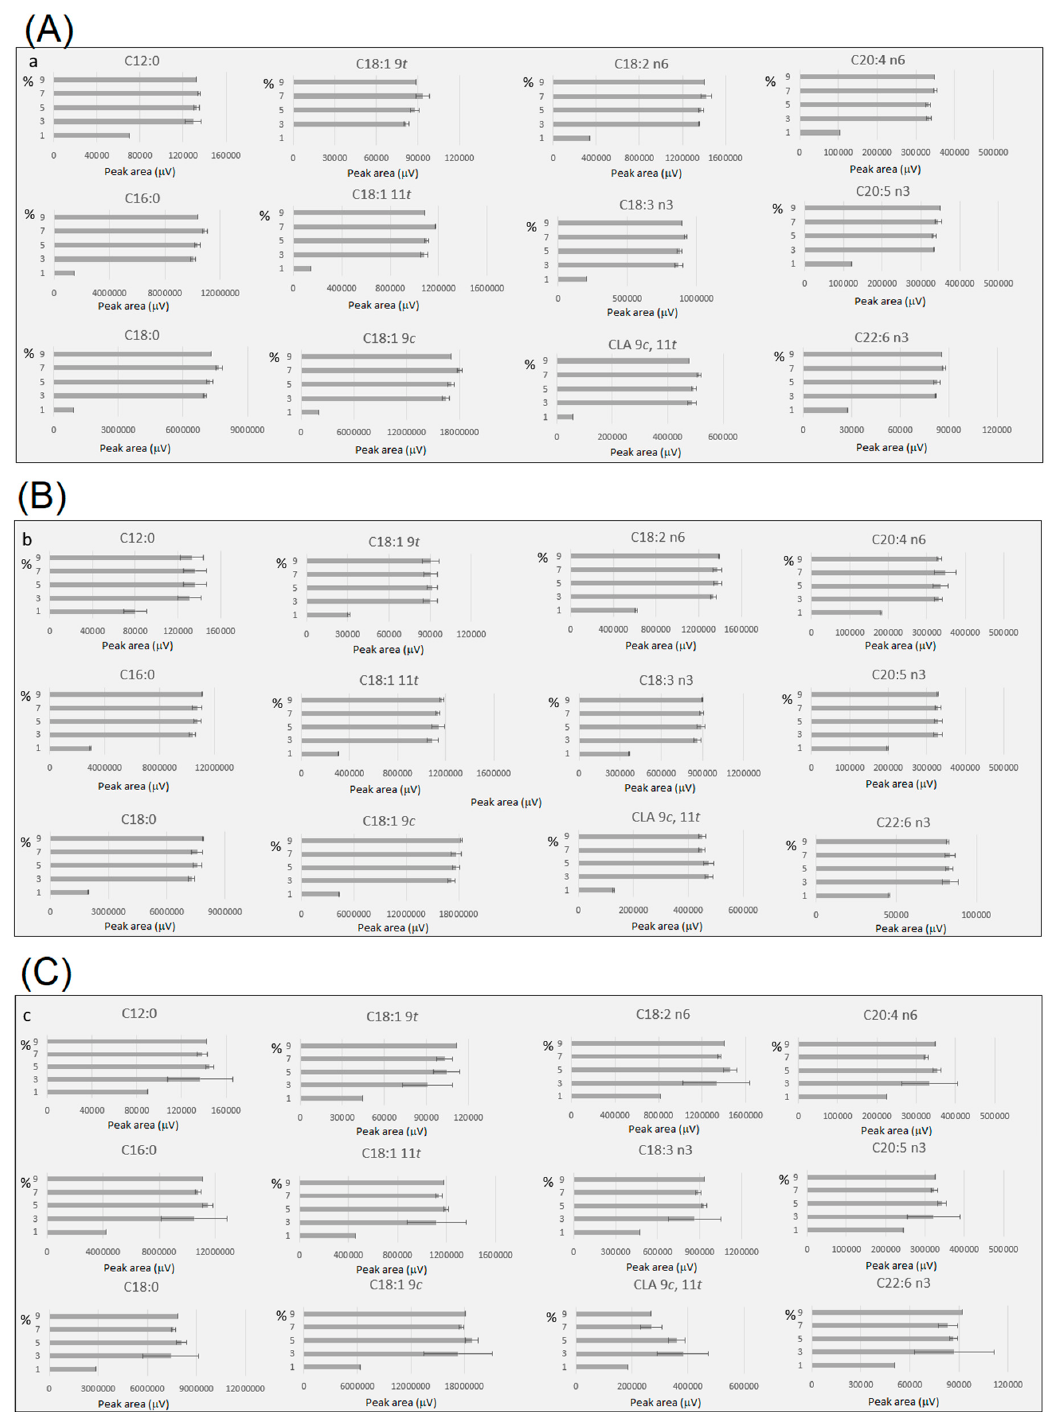
Figure 3. FAMEs yields (peak area normalised by volume of toluene and sample weight) comparison under different acid concentrations under different incubation conditions ( a )—70 °C for 2 h, ( b )—80 °C for 2 h and ( c )—100 °C for 1 h. The samples with a total solvent volume of 8 and 10 mL, a mass range from 200 to 400 mg and moisture between 0 and 7.5% were included to obtain the mean and standard deviation under the different conditions monitored. All experiments contained at least three replicates, except for extreme conditions (acid concentrations of 1 and 9%), where one replicate was performed. For details see Table S1.